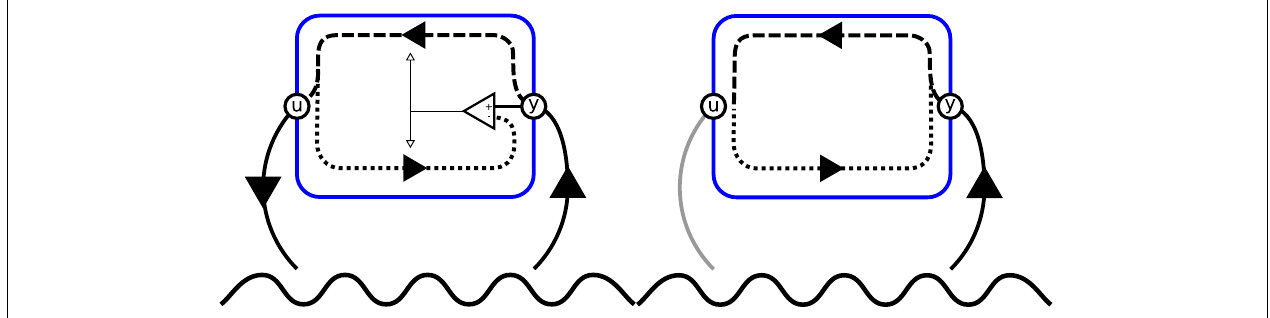
FIGURE 1 | Left, an agent, encapsulated by a blue line, that perceives (y) and acts (u) upon its environment, depicted as a sine wave . The dashed line depicts the inverse model ϕ , and the dotted line represents the forward model ω . The prediction error given by the comparator is used to update both models (white arrow). Right, the same agent conducting internal simulation. Here, output of the forward model is not (only) used for learning but fed back into the inverse model in order to compute the next action. As a result, the iterative process can continue without overt interactions with the world.